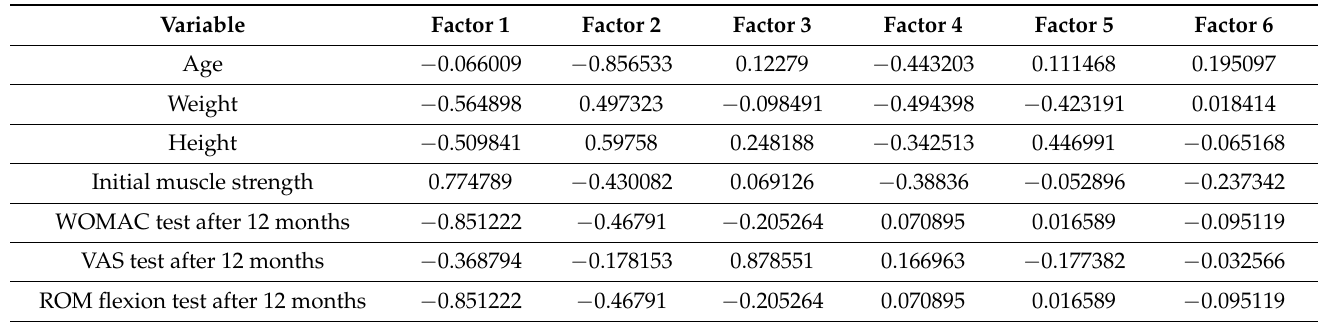
Table 17. Baseline characteristics of the t -test results and factor coordinates of the variables based on correlations with the control group (CG) after 12